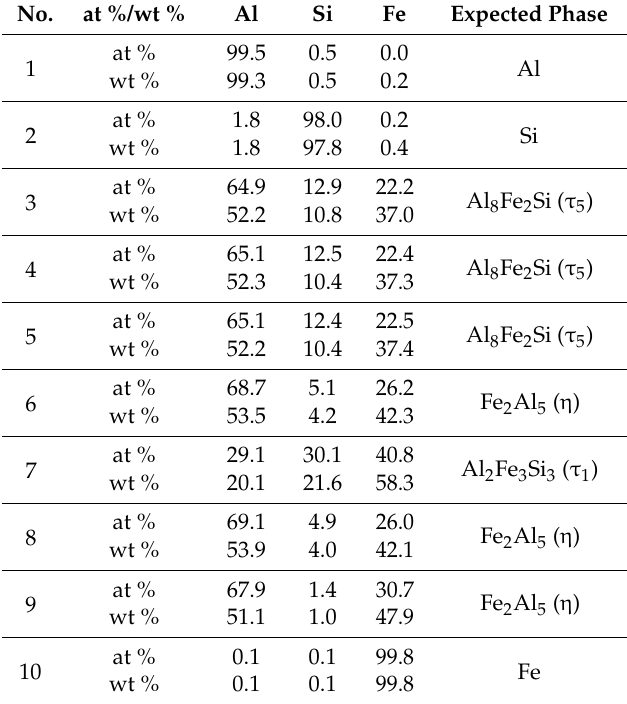
Figure 5. ( a ) High-angle annular dark-field (HAADF) image of Area A in Figure 4a and energy-dispersive spectrometer (EDS) elemental mapping for ( b ) Al, ( c ) Si, and ( d ) Fe, respectively. Table 2. EDS analysis results (at %/wt %) of the phases denoted as 1–10.